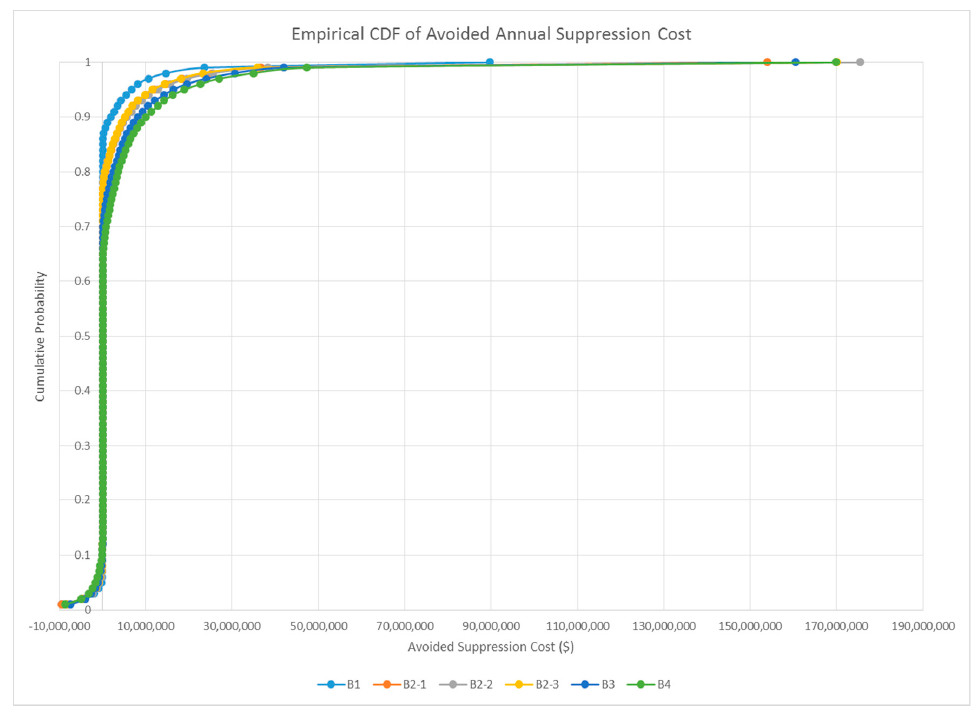
Figure 10. Empirical cumulative distribution function for avoided annual suppression cost. Table 4. Avoid annual suppression cost summary.